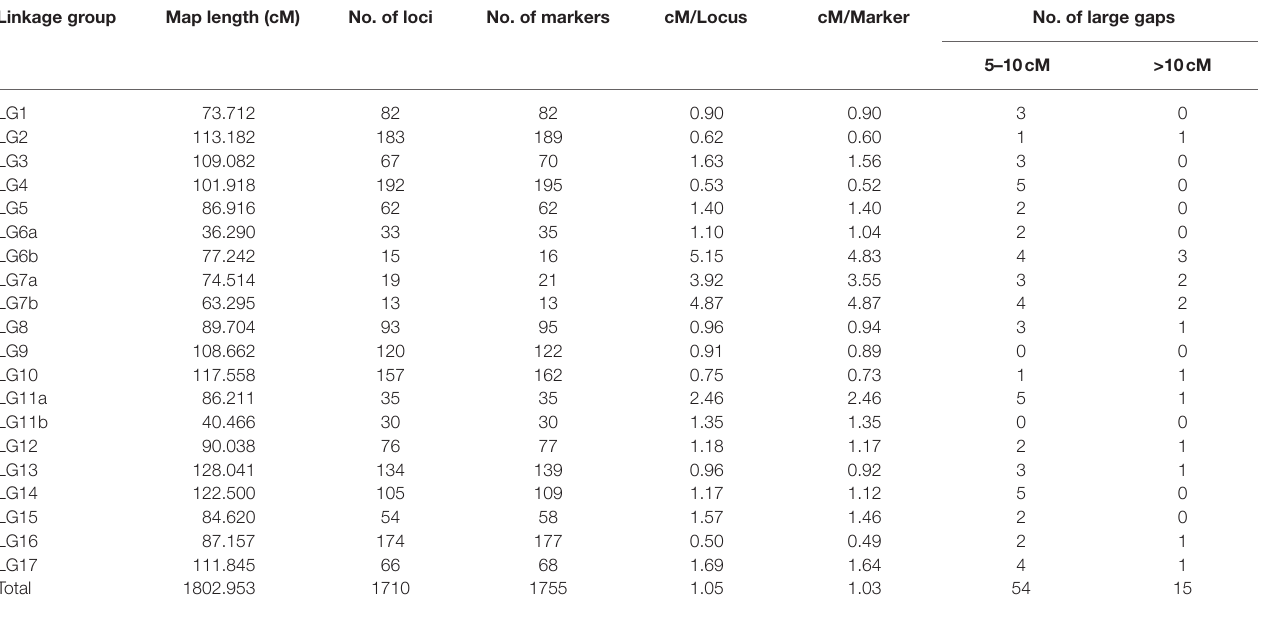
TABLE 4 | Summary of sunflower linkage map developed using SNP markers in an advanced backcross population derived from the cross of HA 89 and wild annual sunflower species, Helianthus praecox . Linkage group Map length (cM) No. of loci No. of